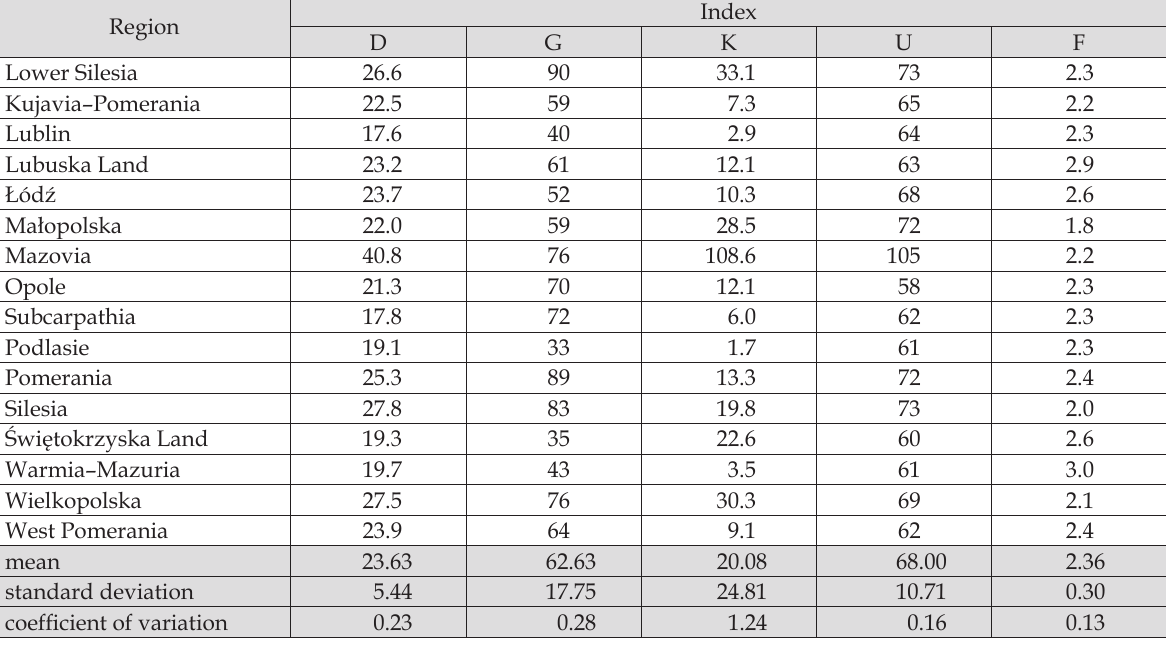
Table 2. Socio-economic indices in 2005